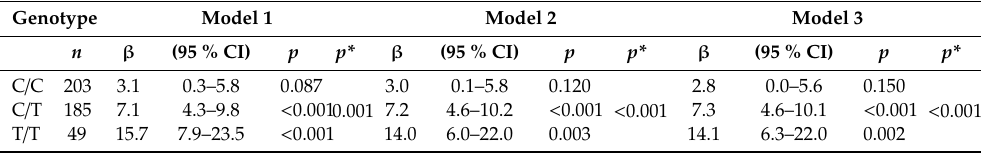
Associations between appetite level and waist circumference (cm), by CLOCK rs3749474 genotype.